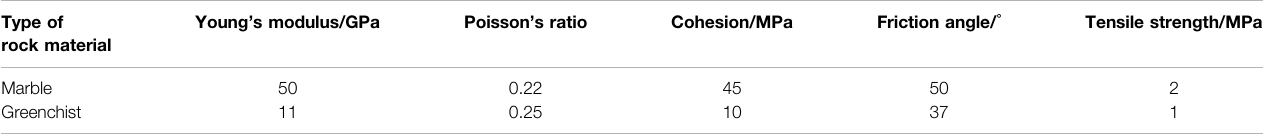
TABLE 2 | Parameters of soft-hard interbedded rock mass in